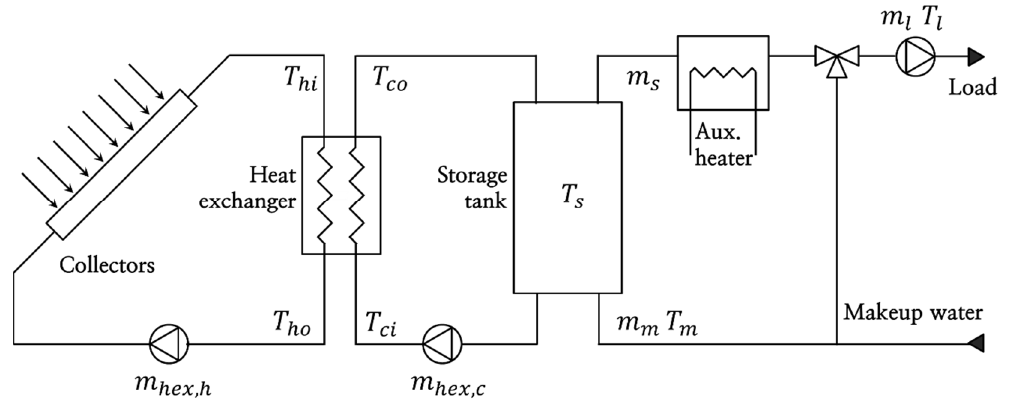
Figure 1. Schematic diagram of an indirect forced circulation solar water heating (SWH)